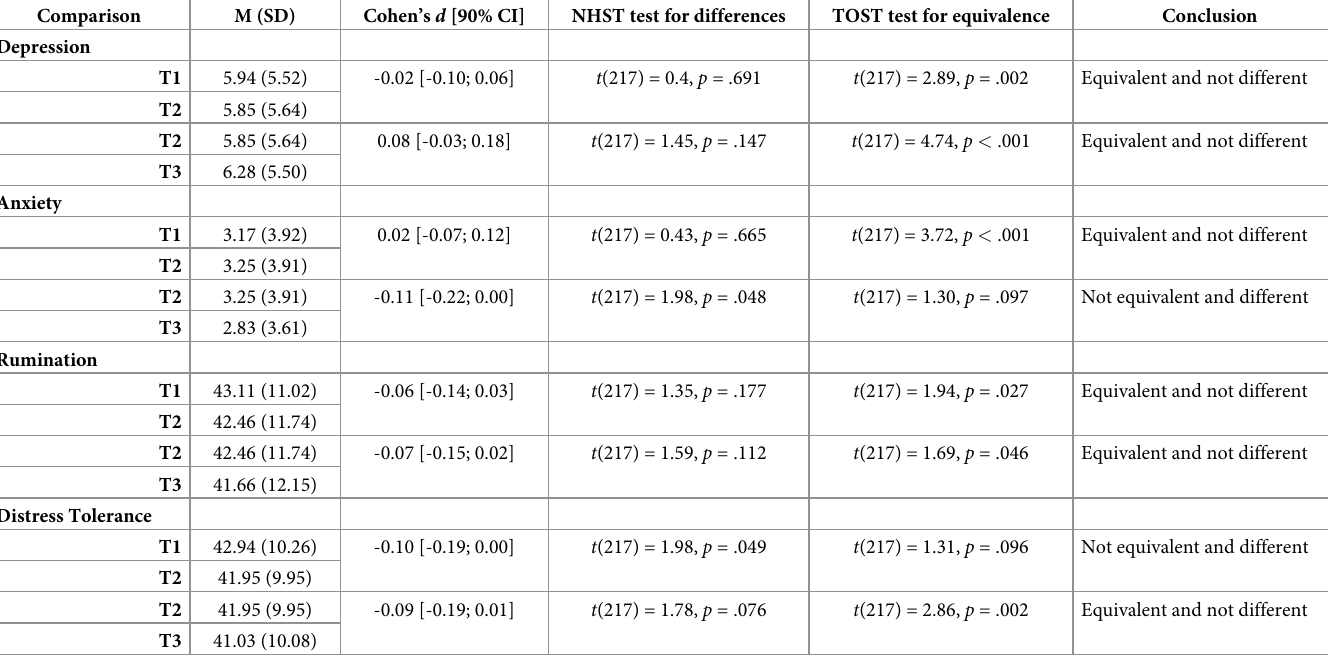
Table 2. Equivalence testing of clinical measures and clinically relevant